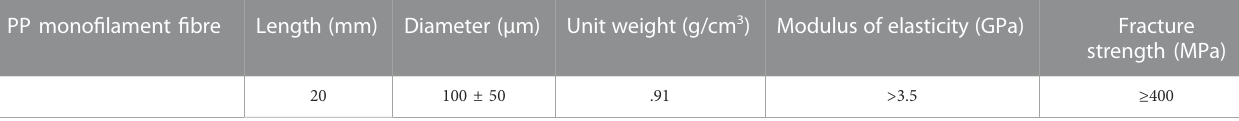
TABLE 2 Geometry and mechanical characteristics of mono fi lament PP fi bre.